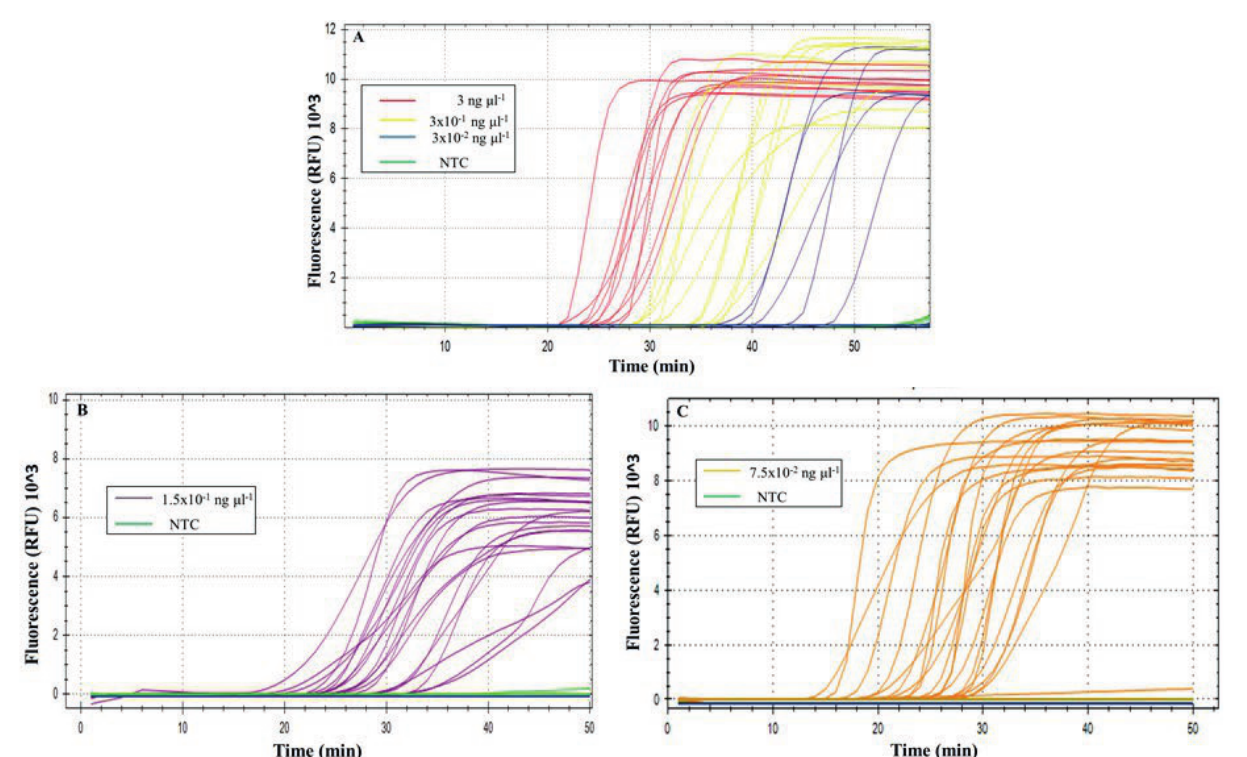
Figure 5. Sensitivity of the RealAmp assay for Pleurostoma richardsiae detection. (A) Results for the preliminary estimate of the LoD: 100% of positive reactions were obtained for target concentrations of 3 ng μL -1 (red curves) and 3 × 10 -1 ng μL -1 (yellow curves); 50% of positive reactions for 3 × 10 -2 ng μL -1 (blue curves); no reaction was observed from 3 × 10 -3 ng μL -1 to 3 × 10 -6 ng μL -1 or in the NTC (green curves). (B and C). Results for the estimate of LoD at 95%: positive reactions with frequency of 100% were obtained analysing target concentration of 1.5 × 10 -1 ng μL -1 (purple curves), and 95% (orange curves) analysing 7.5 × 10 -2 ng μL -1